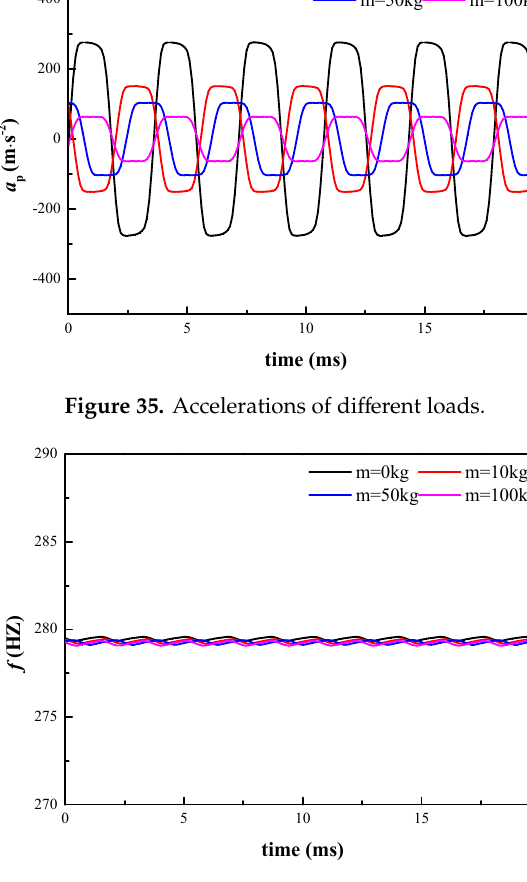
Figure 36. Reversing frequencies of different loads.